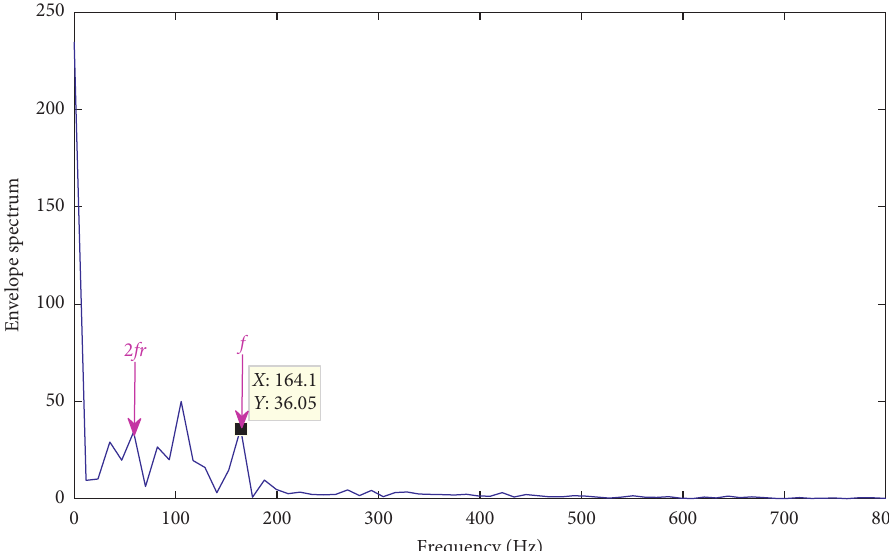
Figure 14: Envelope spectrum of effective mode extracted according to the maximum correlation